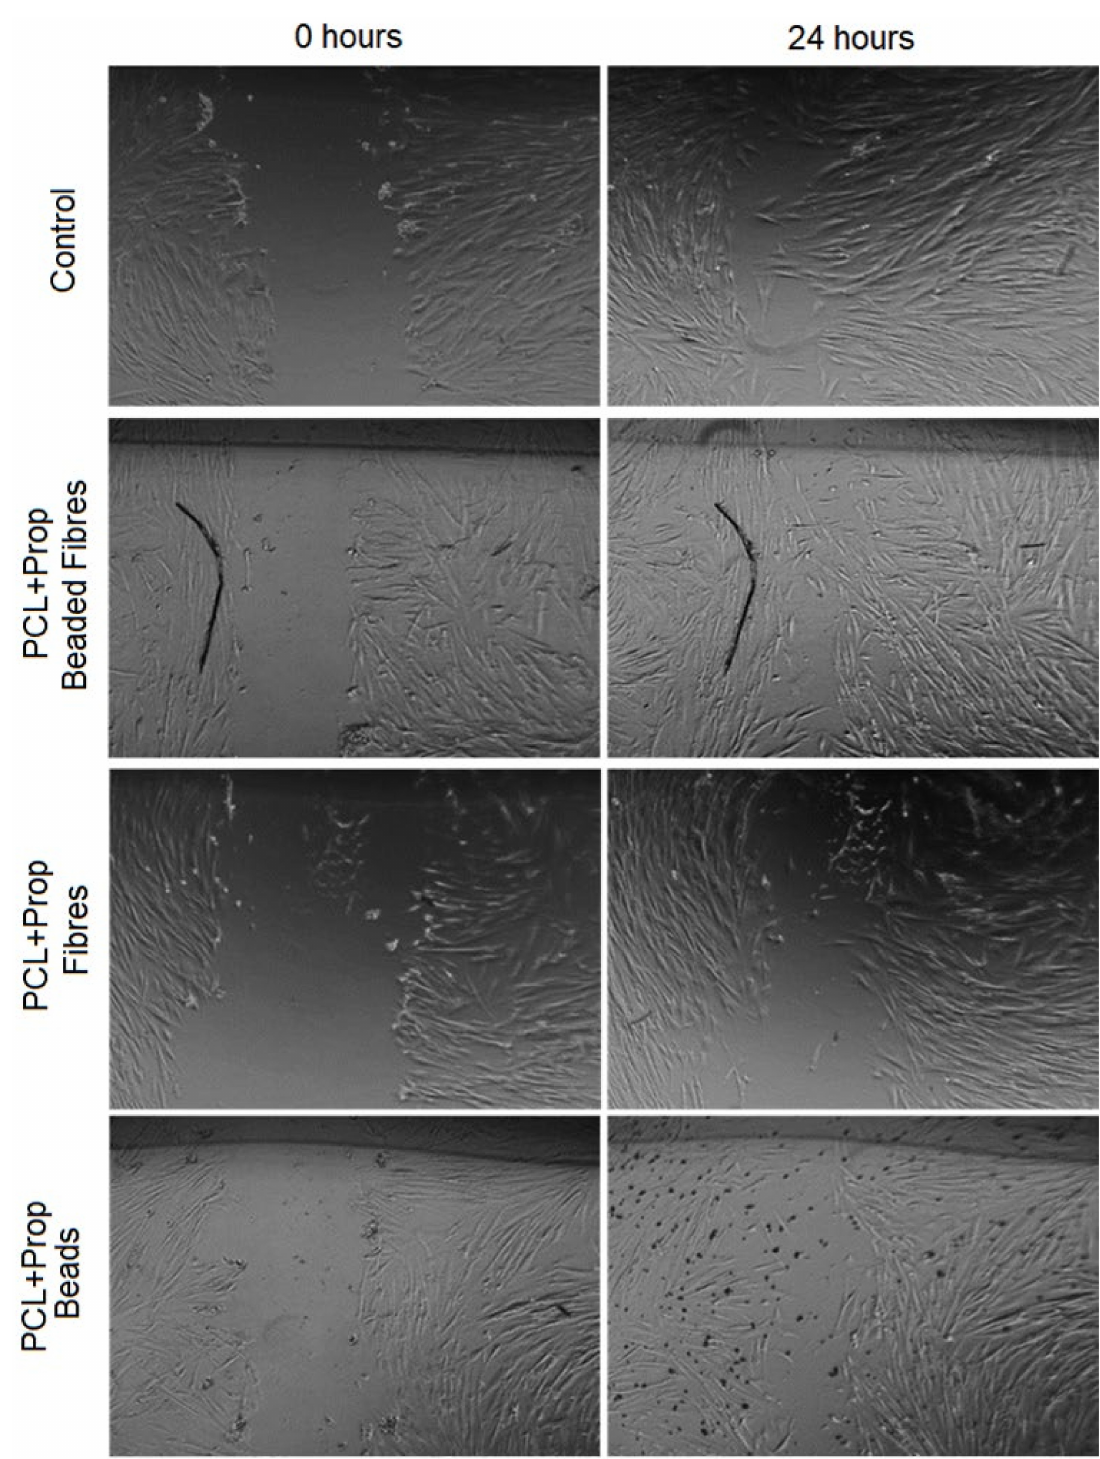
Figure 11. Evaluation of the scratch wound-healing assay using human gingival fibroblast (FGH) cell staining with microscopic inspection of cells stained immediately after scratching (0 h) and after 24 h of wound